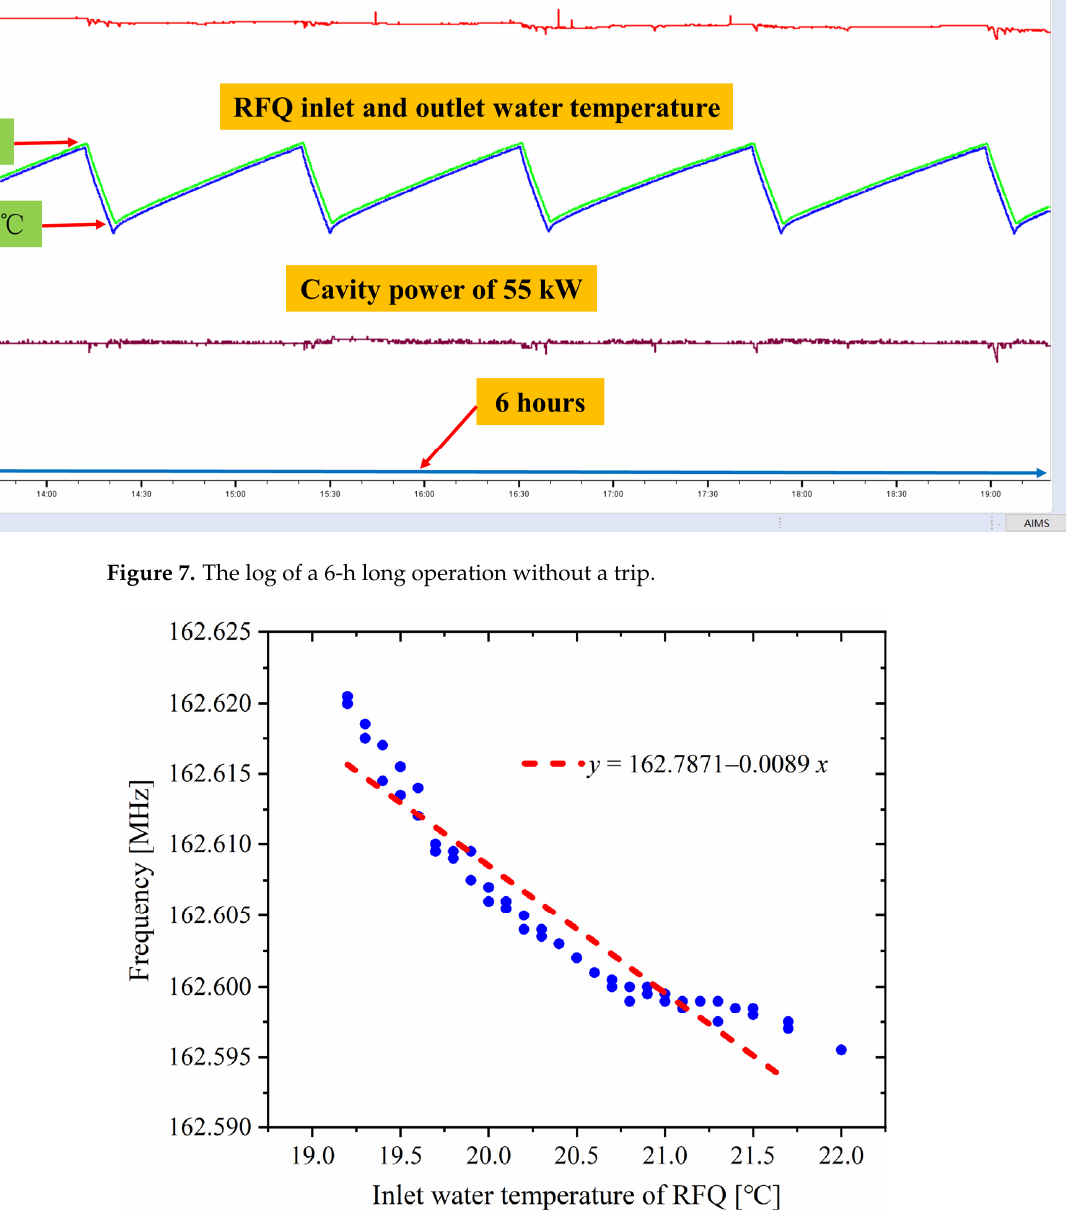
Figure 8. The frequency of the RFQ as a function of inlet water temperature. The inter-vane voltage of RFQ is one of the most important parameters of the cavity. Measurement of the bremsstrahlung X-ray is a useful non-intrusive and precise tech- nique for inter-vane voltage calibration. The bremsstrahlung spectrum originates from the stopping in electrodes of field emission electrons across voltage gaps. X-ray spectra were measured by using a CdTe spectrometer. The spectrometer was calibrated with Am-241 sources, as shown in Figure